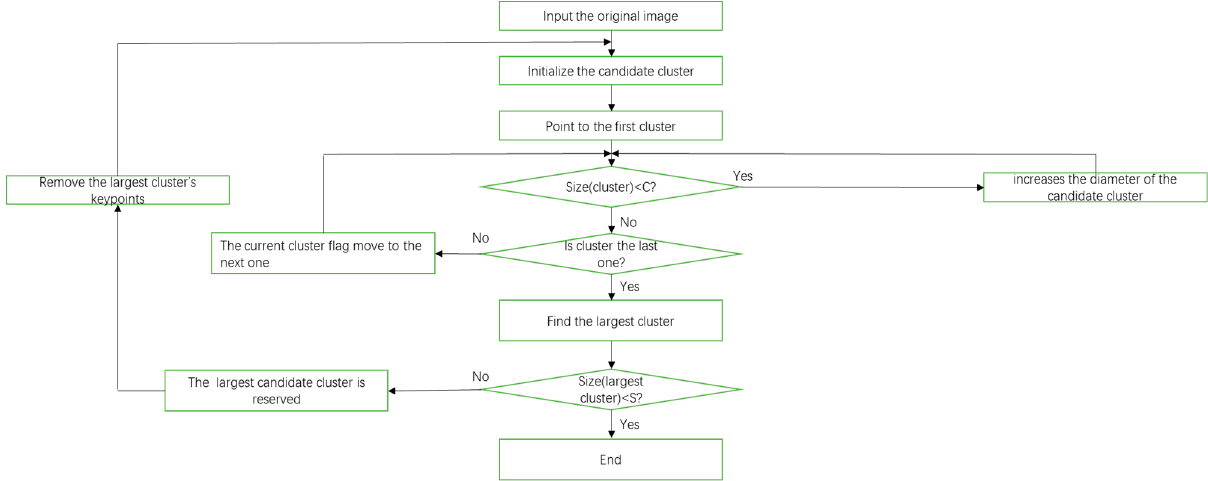
Figure 5. Flow chart for quality threshold (QT)